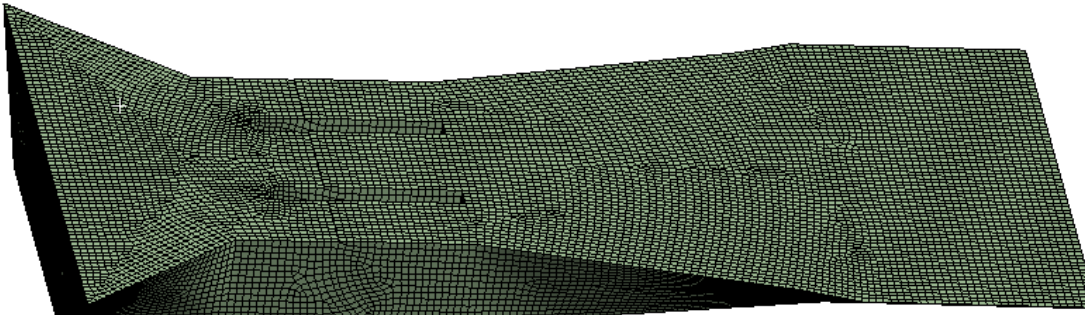
Figure 2. Finite element model of fluid region.